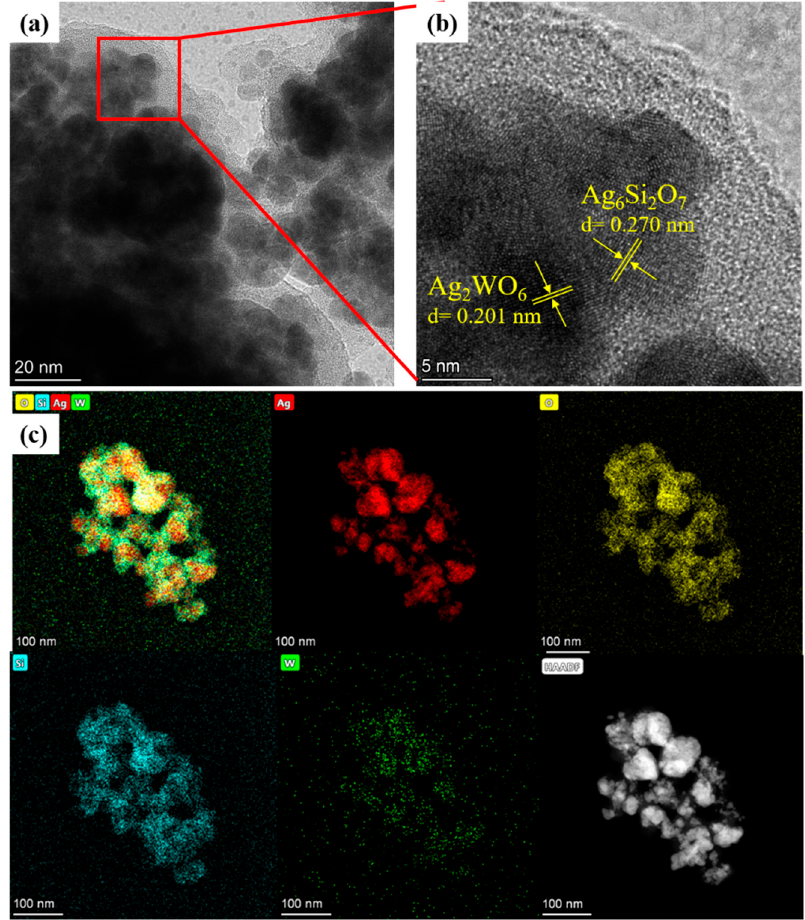
Figure 3. ( a , b ) HRTEM images of the AgSW-4 sample; and ( c ) element mapping images of the AgSW-4 sample (red, Ag; yellow, O; blue, Si; green, W; white, TEM image of sample at the se- lected zone).